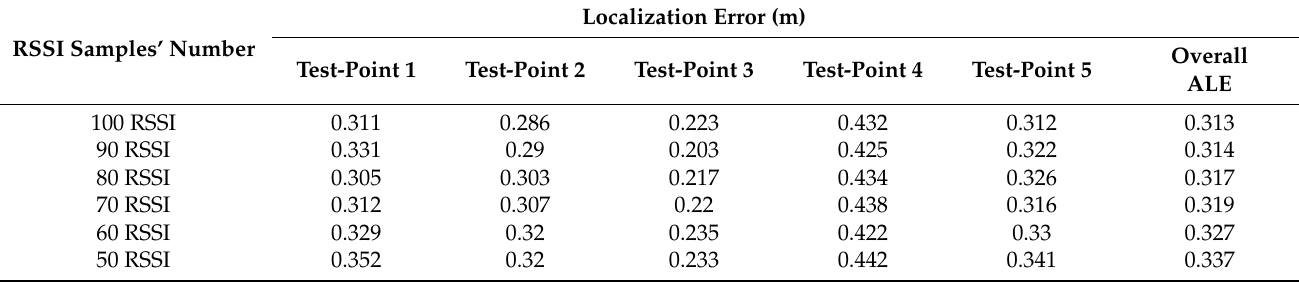
Table 8. The localization errors of the proposed technique at five test points for different RSSI samples’ number in the corridor.